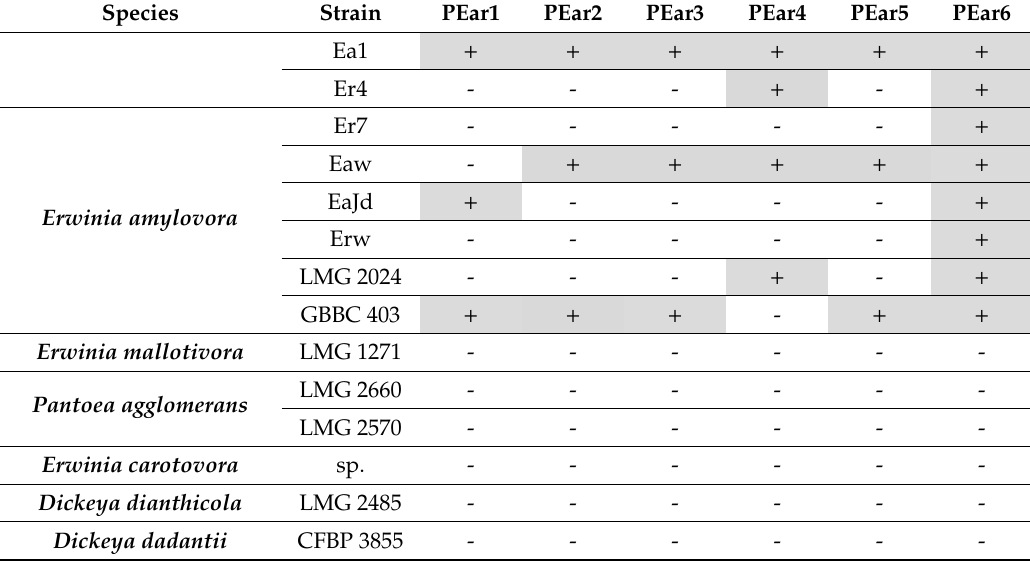
Table 1. Host specificity of isolated phages on various strains. The sensitivity of di ff erent related bacteria of E. amylovora and some di ff erent bacteria to PEar phages was evaluated by plaquing. + (colored in grey): turbid plaques; - (no color): no formation of plaques. Species Strain PEar1